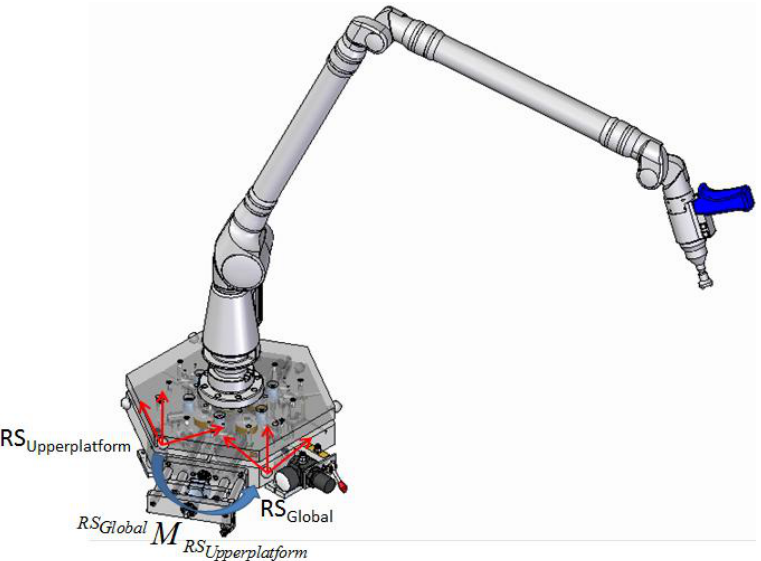
Figure 22. Reference system of the upper platform and fixed lower